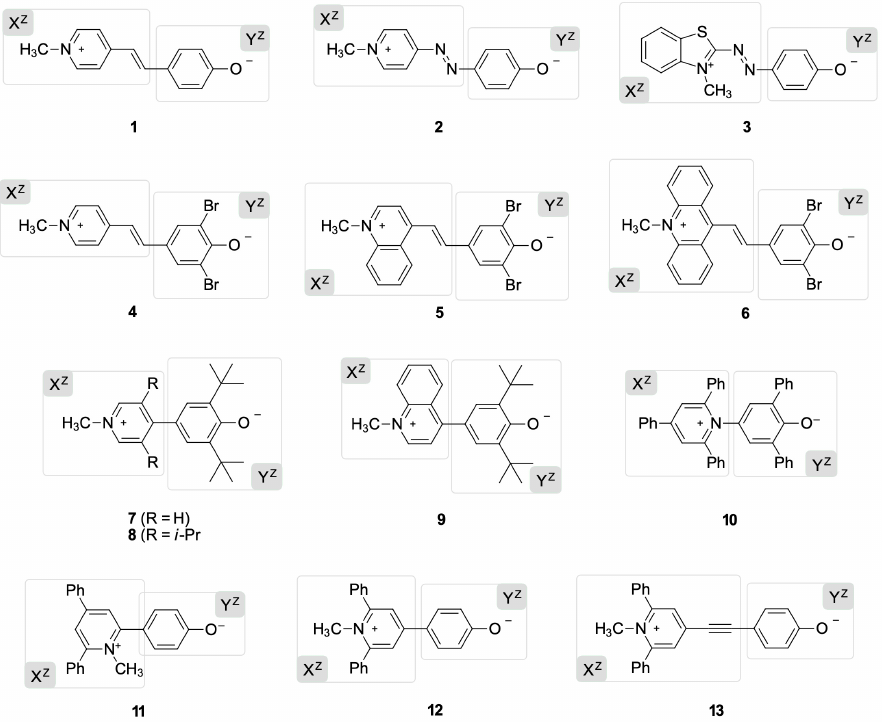
Figure 3. Molecular structures of the solvatochromic phenolate dyes X − Y studied in this work. All molecules are represented with their canonical zwitterionic formulae (Z), indicating how they were split into the X Z and Y Z .